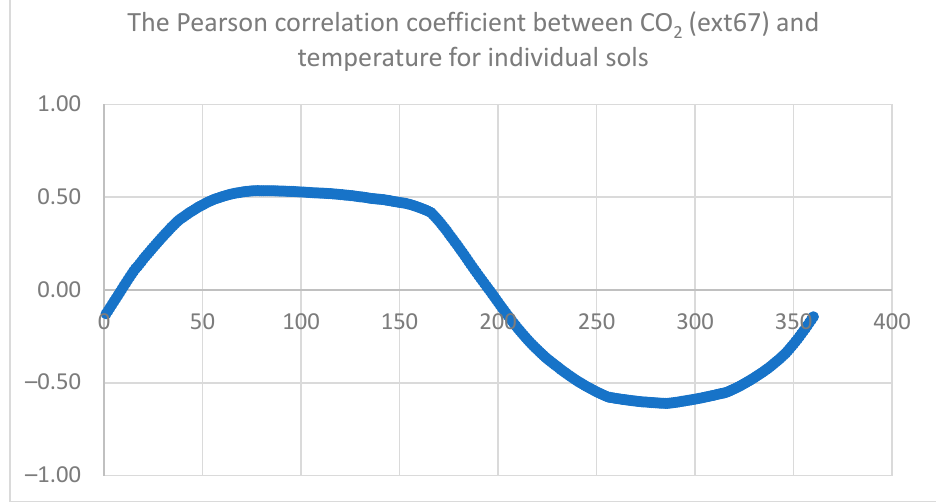
Figure 4. The Pearson correlation coefficient between CO 2 pressure and temperature for individual sols. CO 2 pressure was taken from the MCD database, parameter ext67.